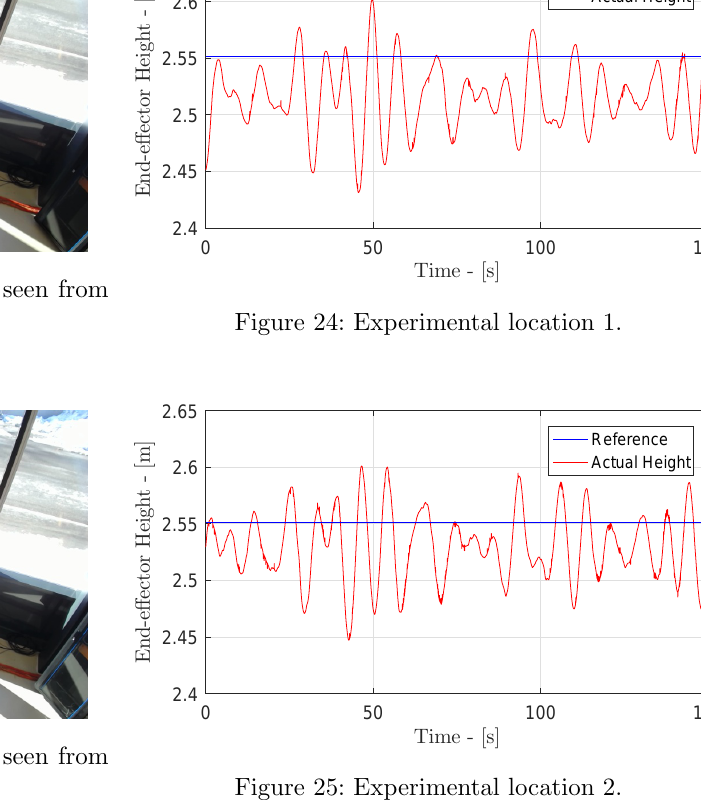
Figure 25: Experimental location 2.